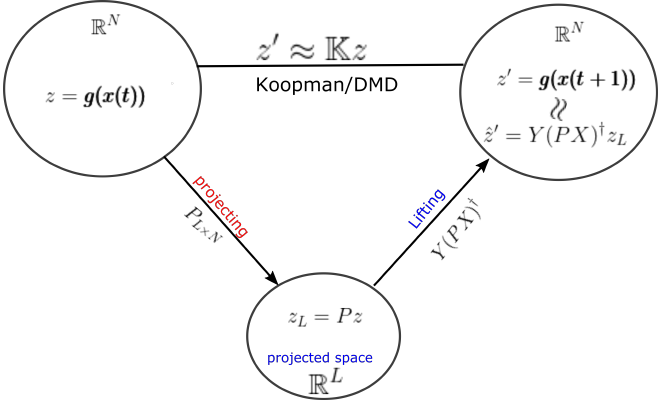
Figure 3. The figure shows the projecting operator P and DMD related lifting operator Y ( PX ) † = K P † , which should be used in DMD algorithms. Instead of using P † as the lifting operator, Y ( PX ) † can be used for efficient calculations. Moreover, notice that ˆ z (cid:48)